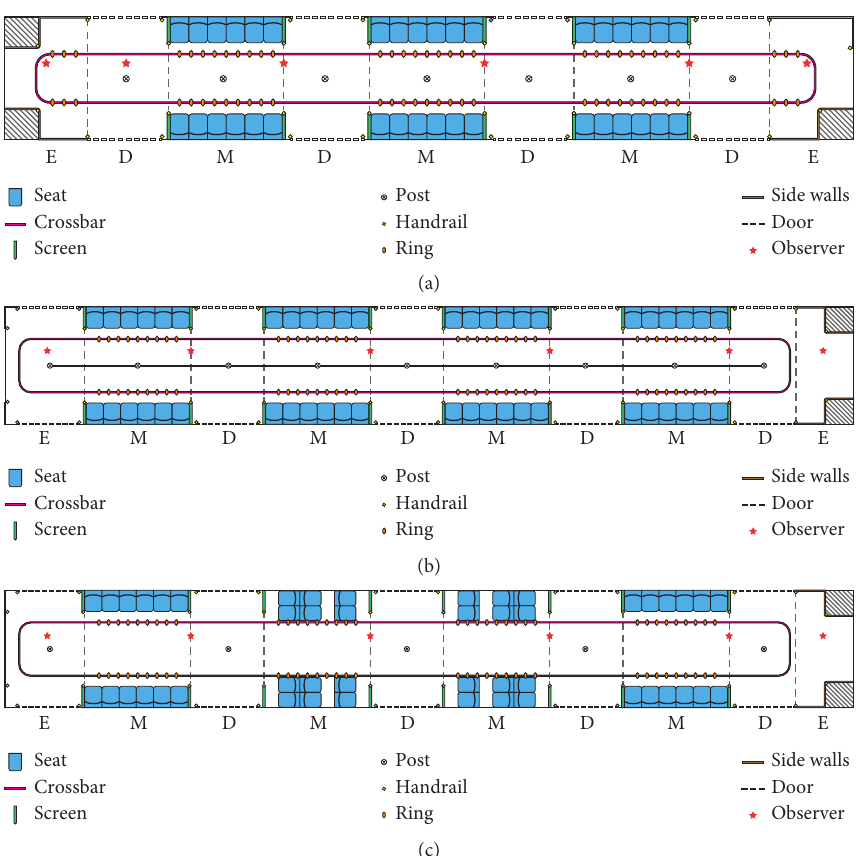
Figure 1: Schematic diagrams of three types of cabins: (a) B-type metro in longitudinal seating layout, 2.8m wide and 19m long; (b) A-type metro in longitudinal seating layout, 3 m wide and 22m long; (c) A-type metro in hybrid seating layout, 3m wide and 22m long. “E” represents the end of the cabin, “D” the door area, and “M” the standing area in the middle of the seats.